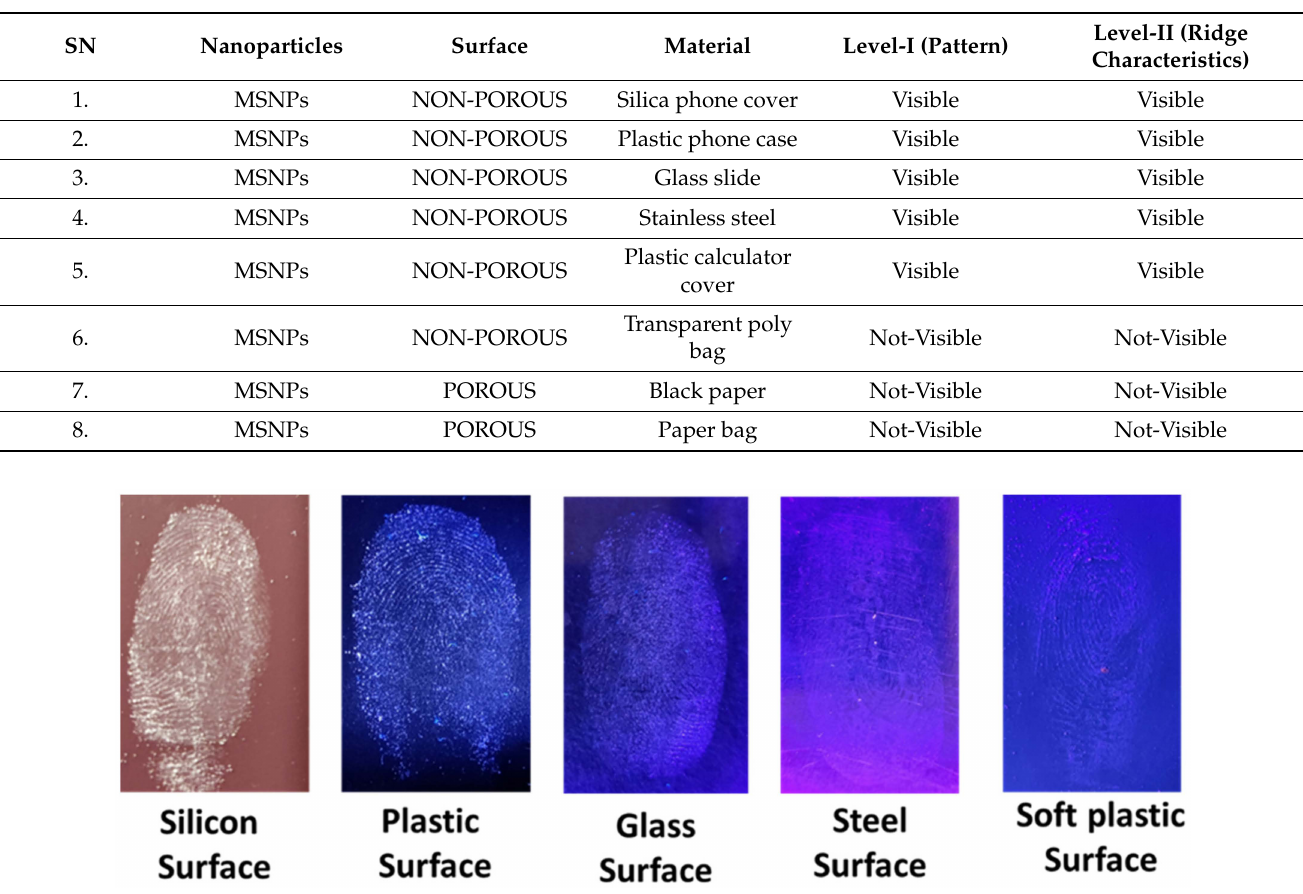
Figure 5. Developed fingerprints on various non-porous surfaces using MSNPs.